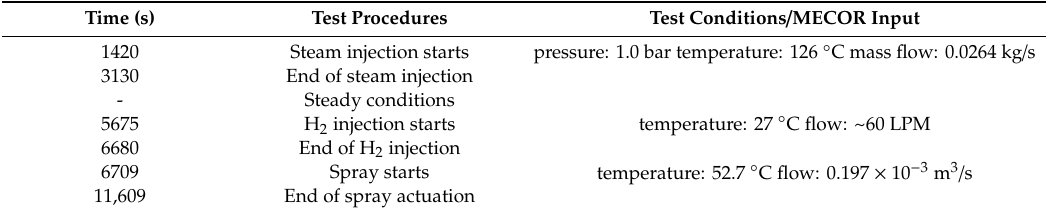
Table 5. Test procedures and boundary conditions applied to MELCOR